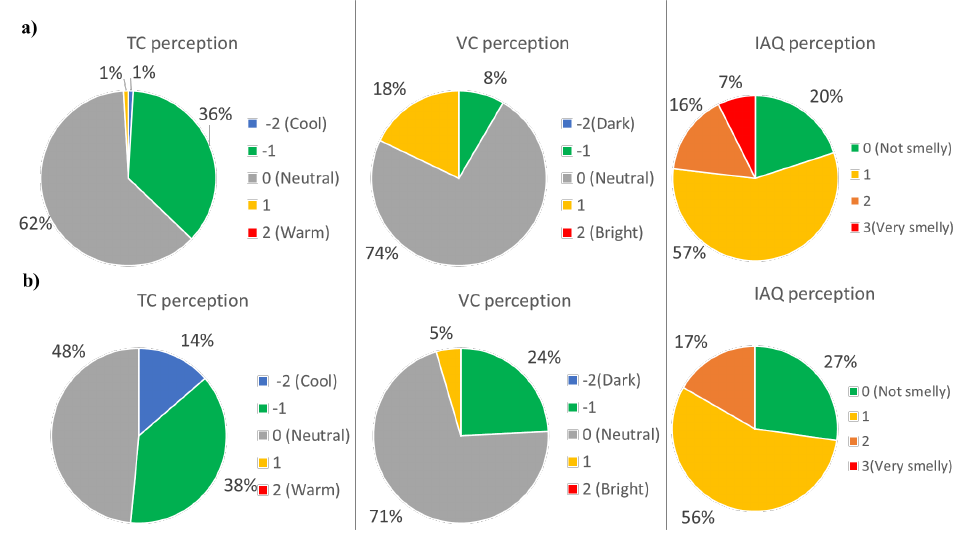
Figure 4. Subjective perception of Thermal Comfort (TC), Visual Comfort (VC) and Indoor Air Quality (IAQ): a) East classroom; b) West